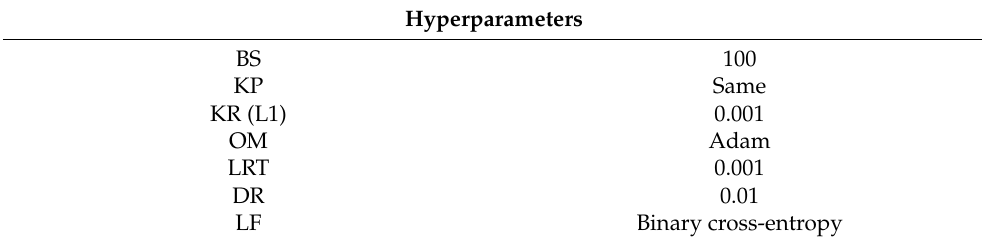
Table 3. Summary of the hyperparameters employed for the 2D-CNN model.